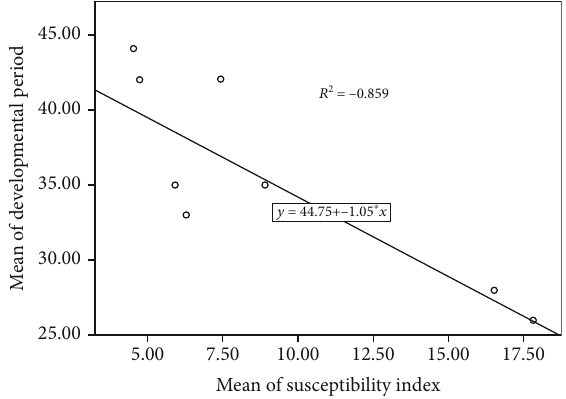
Figure 2: Correlation between DI and beetle developmental period.